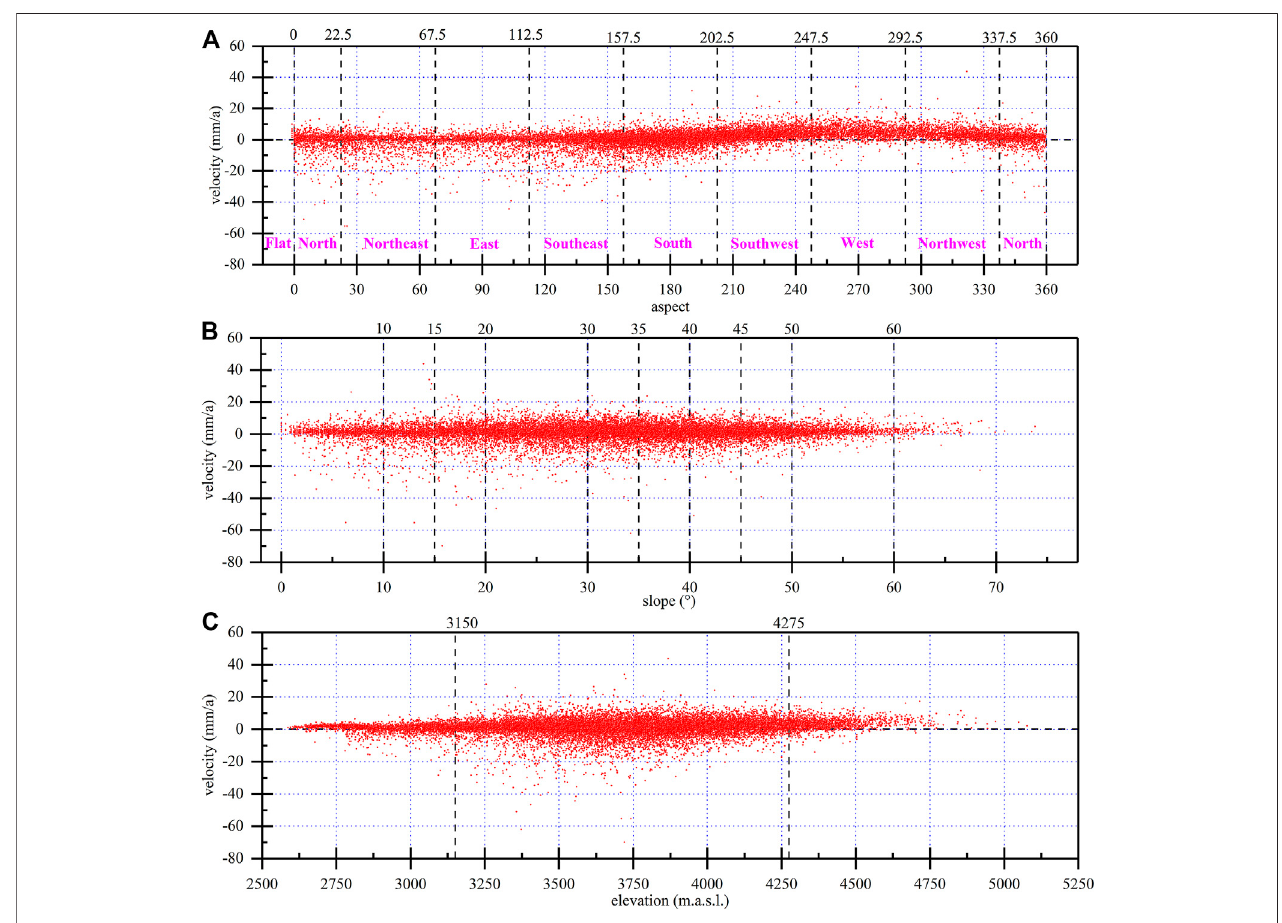
FIGURE 11 | Statistical distribution of terrain factors and deformation [ (A,B,C) show the relationship between aspect, slope, and elevation, respectively].